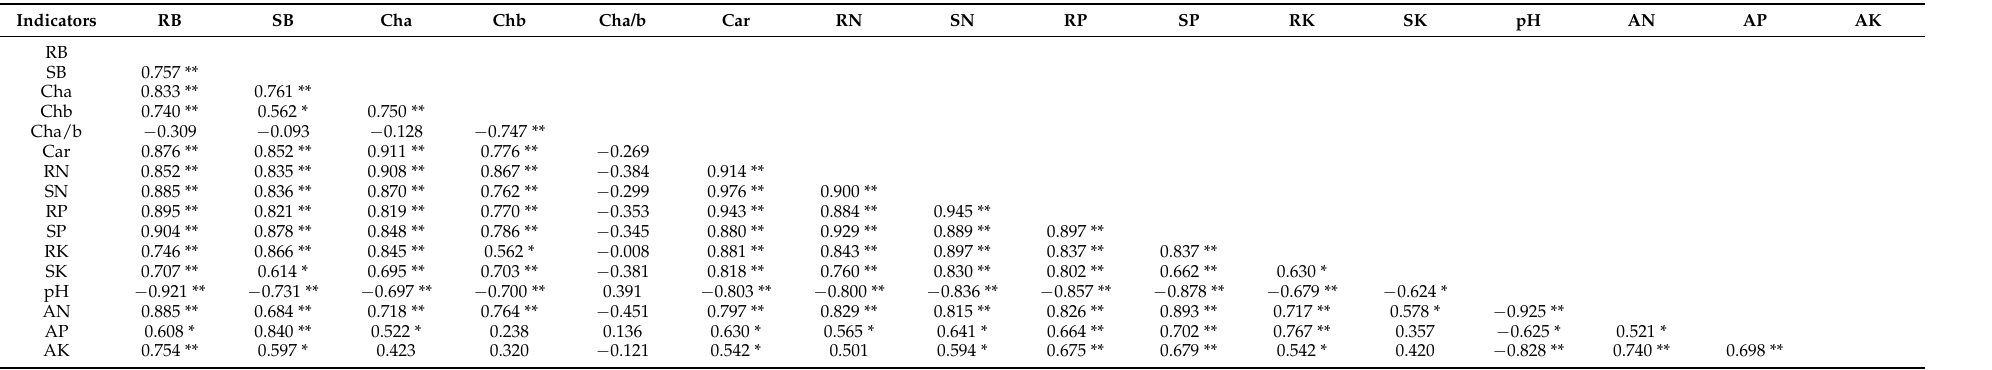
Table 3. Correlations among the different indicators of loquat